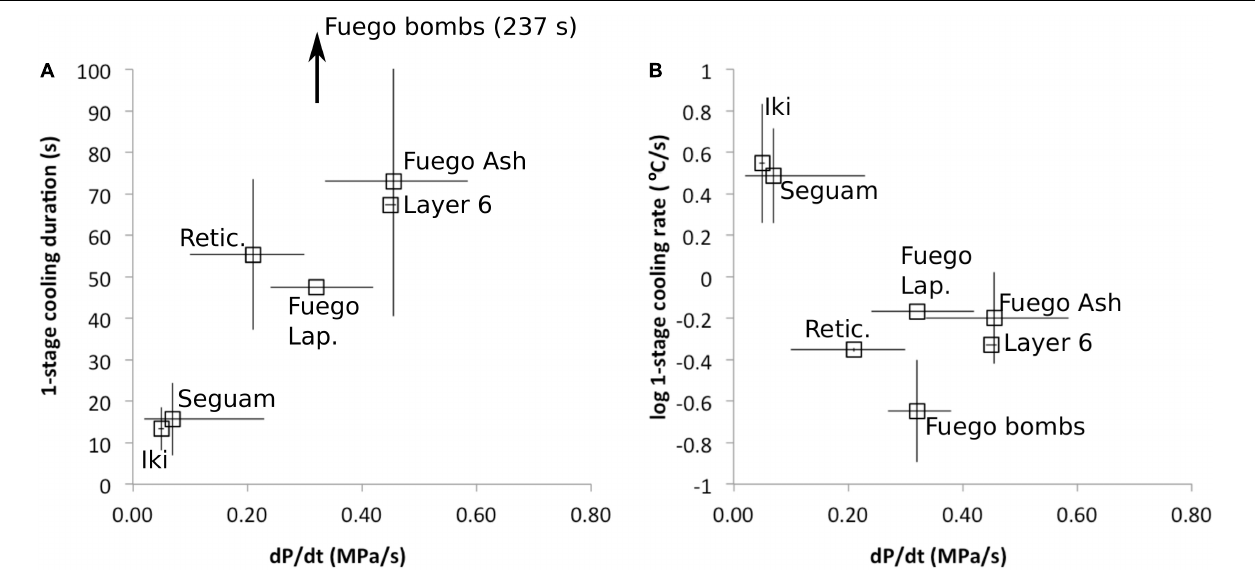
FIGURE 6 | Average best-fit cooling durations and cooling rates versus best-fit decompression rates for each eruption. Decompression rates (and associated error bars) are from the one-stage ascent models of Lloyd et al. (2014), Ferguson et al. (2016), and Newcombe et al. (2020). (A) Average best-fit cooling durations are positively correlated with magma decompression rate. Melt inclusions from the subplinian eruptions (Fuego and the Keanak ¯ ako’i layer 6 deposit) experienced longer durations of syneruptive cooling and higher magma decompression rates on average than inclusions from the fire-fountain eruptions (Seguam, Kilauea Iki, and the Keanak ¯ ako’i Reticulite). (B) Average best-fit cooling rates are negatively correlated with magma decompression rate. Inclusions from the subplinian eruptions experienced slower cooling, consistent with cooling during ascent in the conduit just prior to quenching on eruption (and/or cooling in the volcanic plume), while inclusions from the fire-fountain eruptions experienced rapid cooling, consistent with sub-aerial quenching, but not consistent with significant cooling in the conduit just prior to eruption.